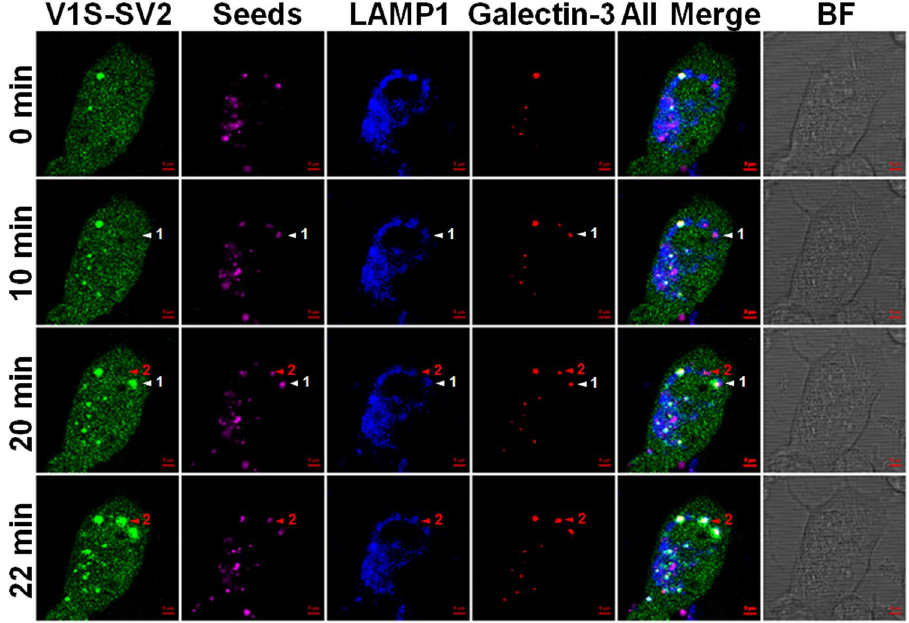
Figure 7. Endo-lysosome rupture precedes formation of α S inclusions in endocytosis-mediated seeding. H4/ V1S-SV2/LAMP1-eCFP/mCherry-Galectin-3 cells were incubated with DyLight ® 650 labeled SAg-2d for 2 days then a single cell forming α S inclusions was chosen for time-lapse imaging under confocal microscopy. White and red arrowheads respectively denote the sequential events during the formation of two different α S inclusions (No. 1 and No. 2). Scale bar: 1 µ